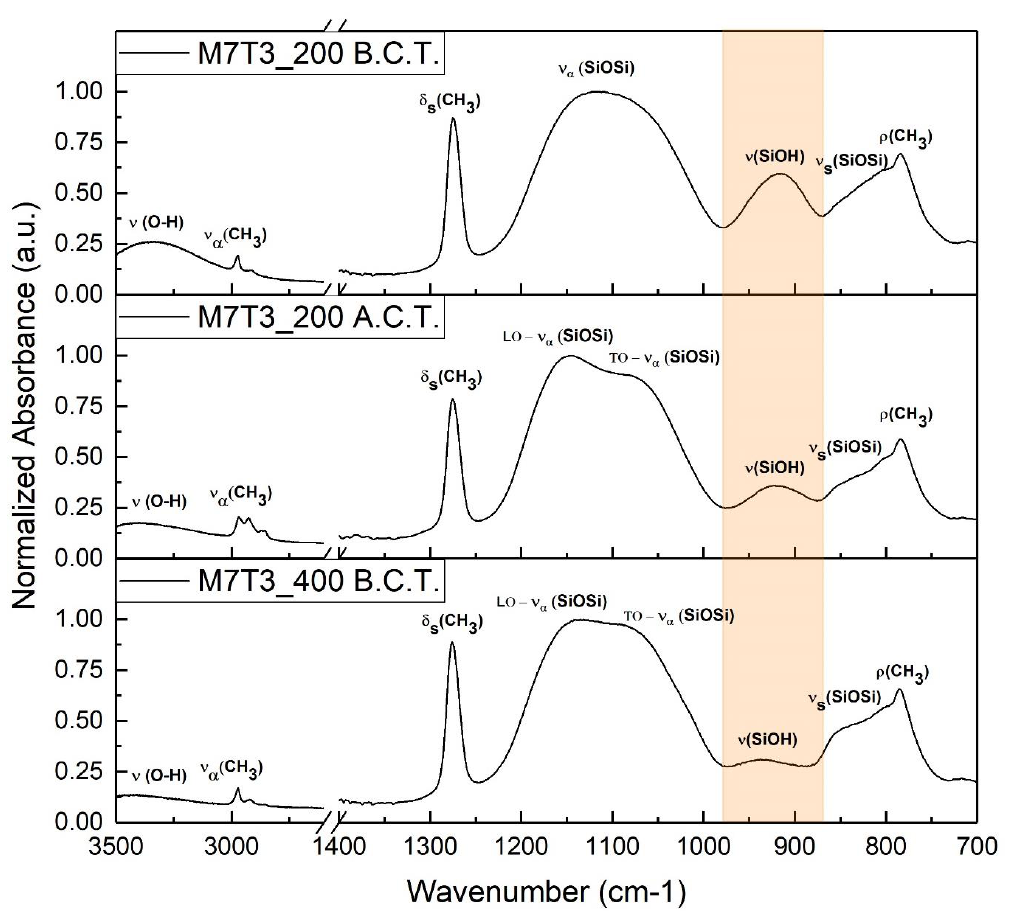
Figure 4. FTIR spectra of M7T3_200 (before and after condensation test, B.C.T. and A.C.T., respectively) and M7T3_400 coatings.